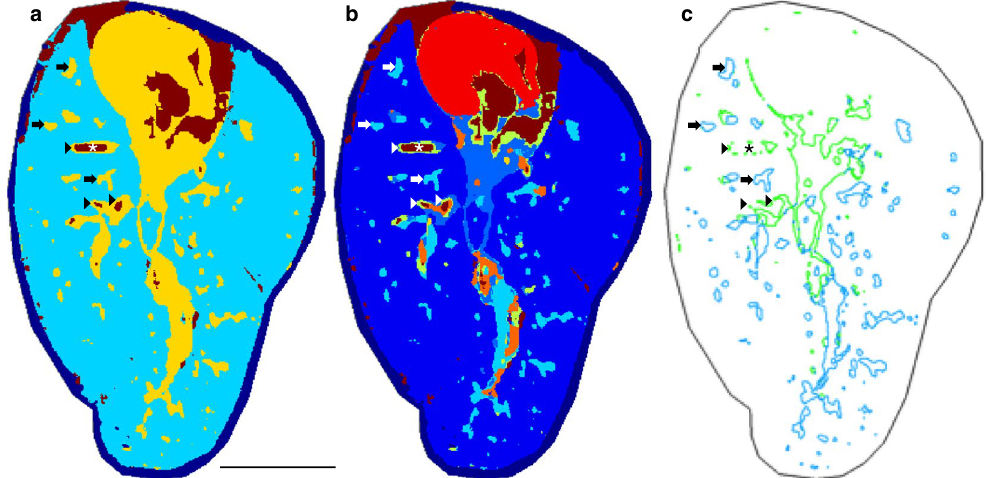
Figure 4. Unsupervised clustering is sufficient to discriminate endothelial vasculature from epithelial airway structures within nine segments. ( a ) Three-component segmented image (three clusters on-tissue) given in false color, dark blue component is off-tissue. ( b ) Nine-component segmented image (nine clusters on-tissue) given in false color, dark blue component is off-tissue. ( c ) Pixels defining the edges of the segment characterized by the average spectrum representing endothelial-lined vascular structures (lime) and the epithelial-lined airway structures (blue). Scale bar = 5 mm. Annotations: asterisk - vessel containing blood, arrowheads - endothelial- lined vascular structures, arrows - epithelial-lined airway structures. MALDI-TOF, negative ion mode, 50 μ m spatial resolution, normalized to TIC.